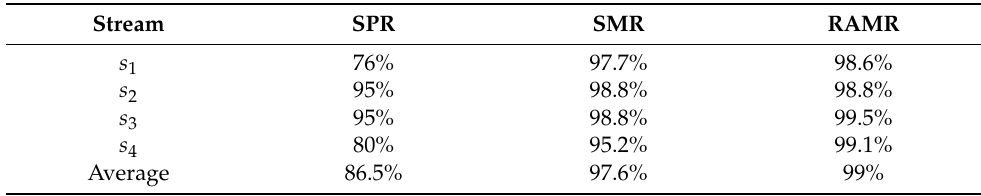
Figure 4. Illustrative example of routing results from Reliability-Aware Multipath Routing (RAMR). Table 2. Comparison of the probability of SMR, shortest path routing (SPR) and RAMR routing algorithms.